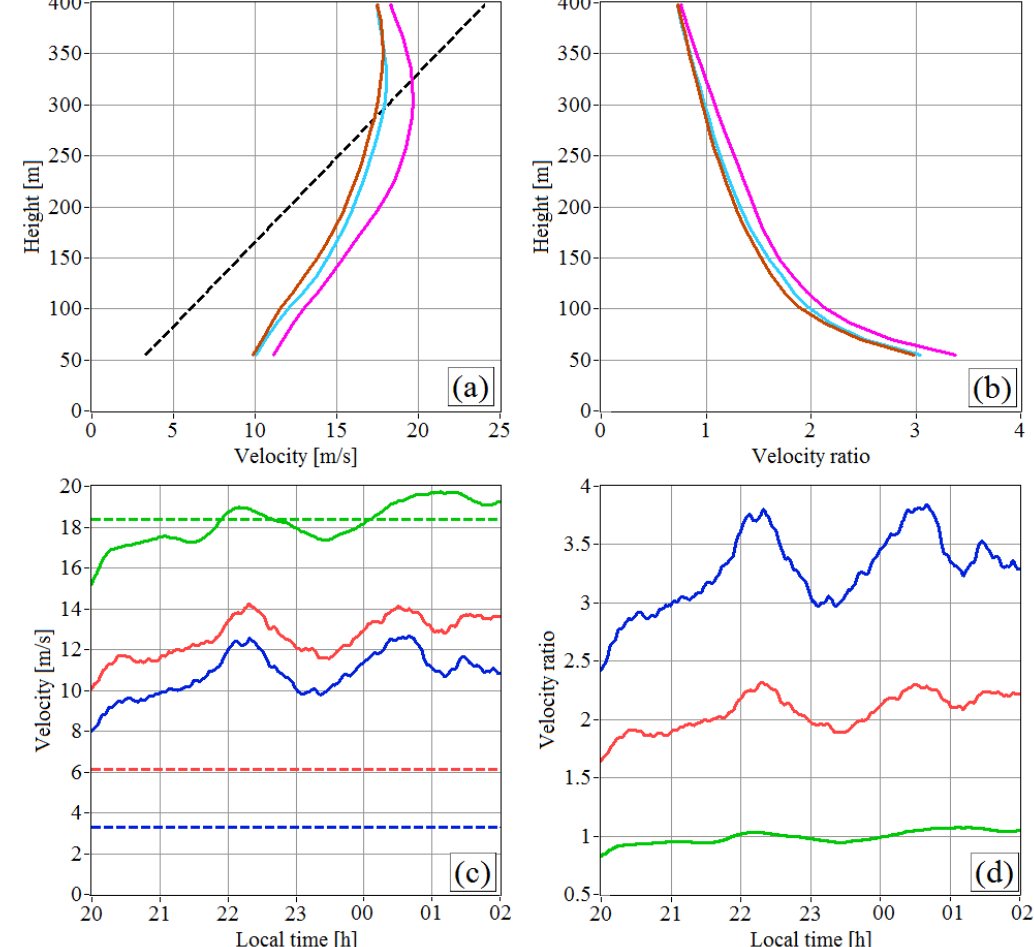
Figure 5. Vertical profiles ( a , b ) at 21:00 LT (brown curves), 23:00 LT (pale-blue curves) and 01:00 LT (pink curves) and time series ( c , d ) at a height of 55 m (blue curves), 100 m (red curves) and 300 m (green curves) for the mean wind velocity ( a , c ) and the ratio of the mean wind velocity to the linear speed of the probing volume motion µ ( b , d ). The data are taken from Figure 4. The dashed lines show the linear scanning speeds at the corresponding heights.